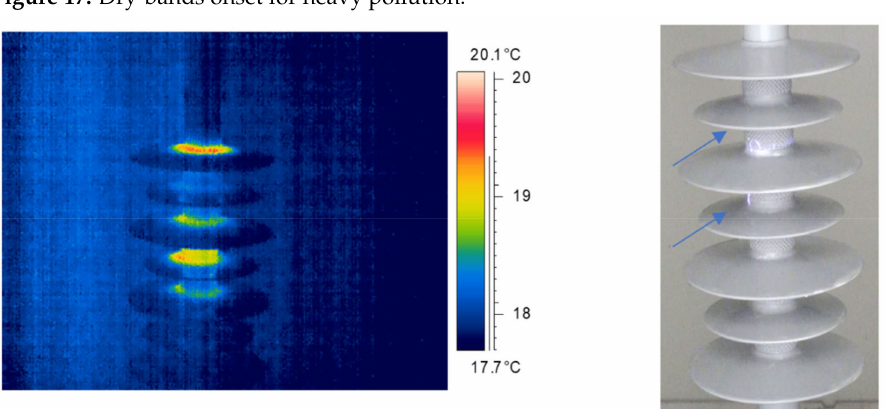
Figure 18. Dry-bands and firsts discharges inception/development for heavy pollution.